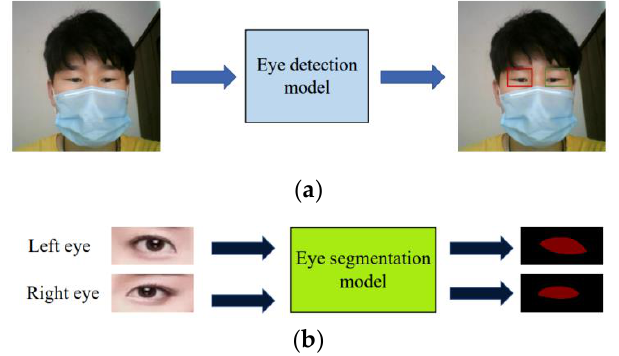
Figure 5. Eye detection ( a ) and segmentation process ( b